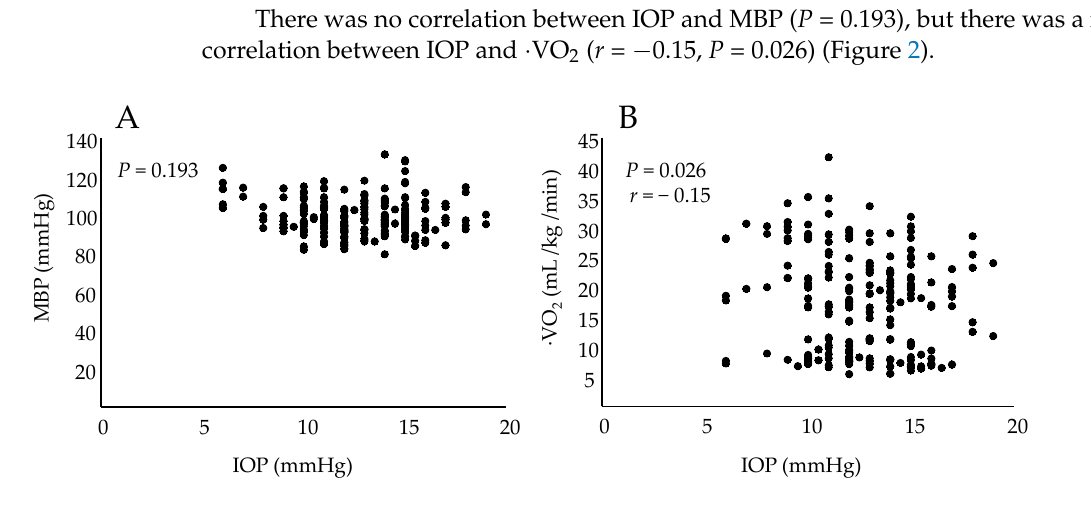
Figure 2. ( A ) Relationship between intraocular pressure and mean arterial pressure (MBP). ( B ) Re- lationship between intraocular pressure and oxygen consumption during exercise (VO 2 ). Table 1. Differences in intraocular pressure, blood pressure, and oxygen uptake at each exercise intensity.